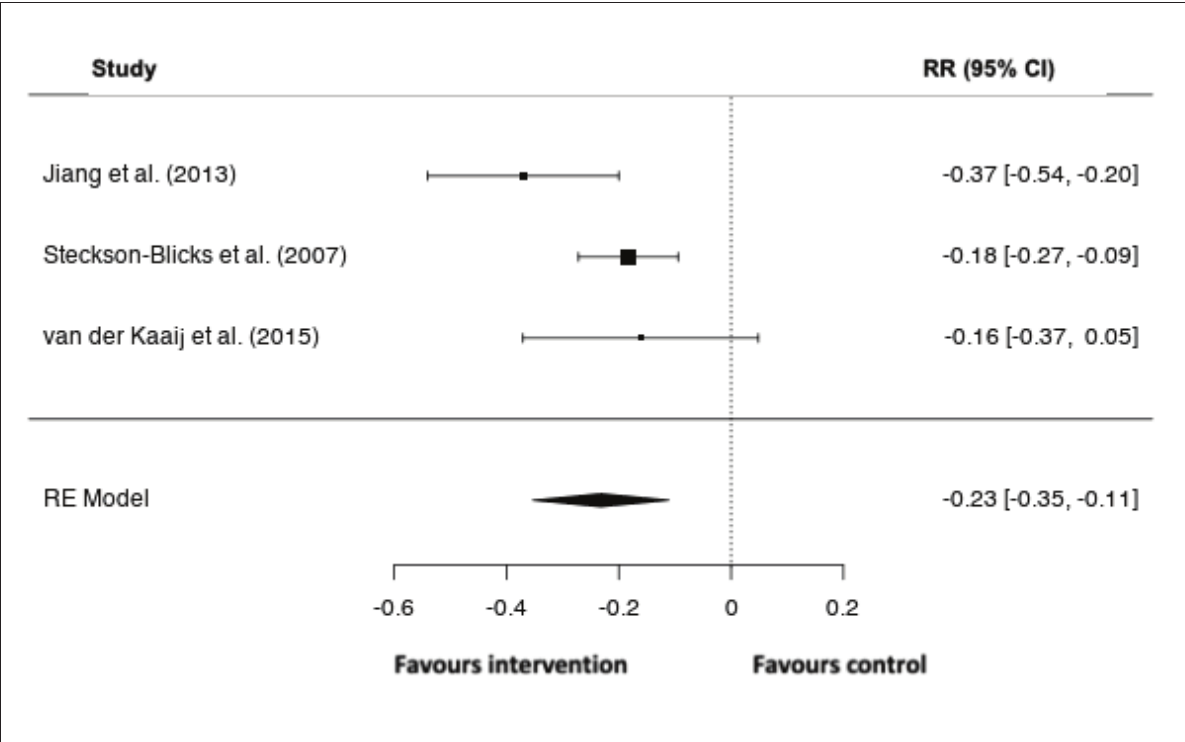
Figure 3. Meta-analysis of WSL risk reduction with fluoride interventions, using a random-effects model. The forest plot shows the pooled effect of fluoride on WSL